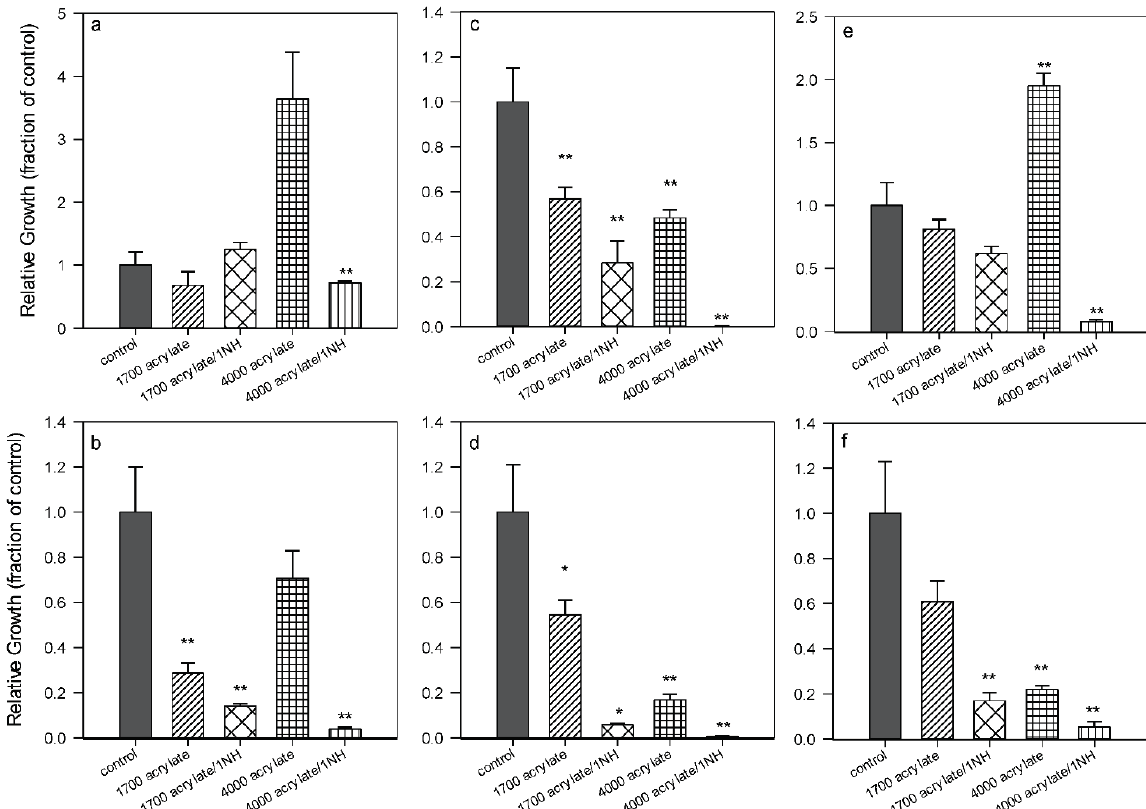
Figure 2. Effect of acrylate (1) and ammonium oligomer (5) chain lengths. Pseudomonas aeruginosa ( left ), Staphylococcus aureus ( middle ), Staphylococcus epidermidis ( right ). ( a ), ( c ), ( e ) = bacteria suspended in the supernatant medium; ( b ), ( d ), ( f ) = bacteria attached to the control (polystyrene) or polymer surface. * , difference in values significant at p ≤ 0.05, ** difference in values significant at p ≤